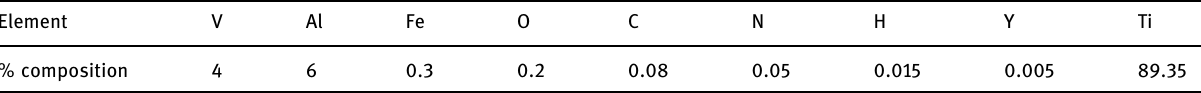
Table 1: Nominal ( wt% ) constituent of B265 titanium alloy